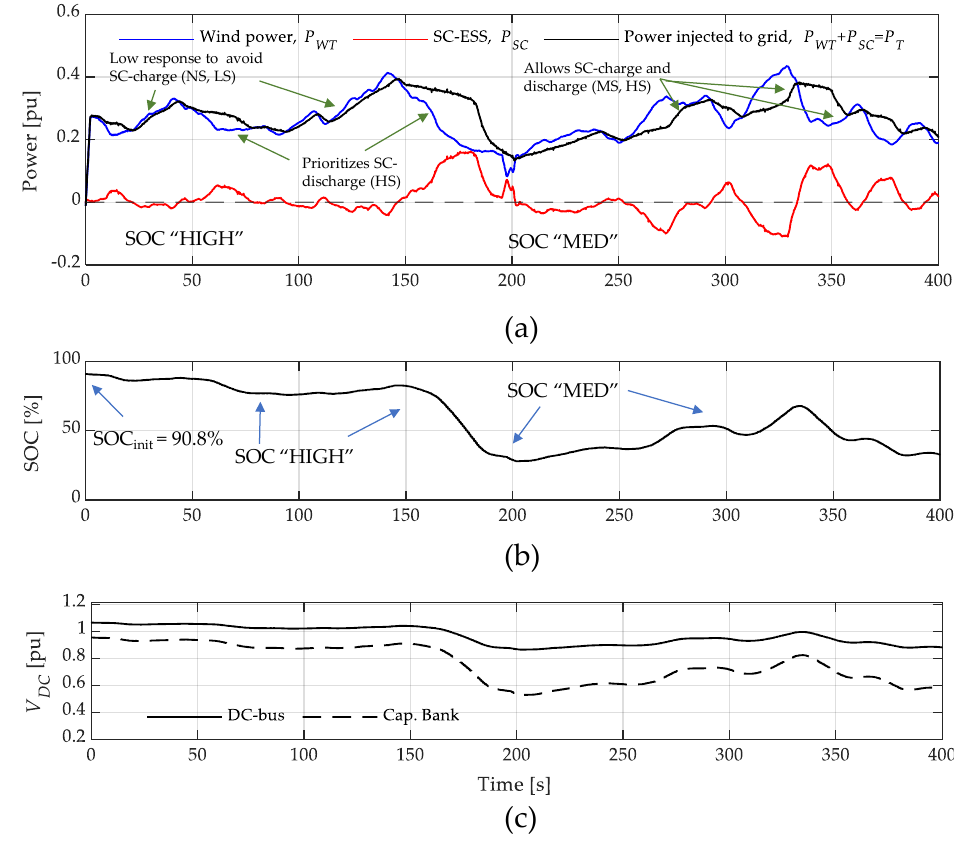
Figure 18. Experimental results in SC–ESS overcharge condition: ( a ) original injected wind power (blue), power delivered by SC–ESS (red), combined wind-supercapacitors effect with the smoothing algorithm (black); ( b ) evolution of SOC; ( c ) DC voltage of the supercapacitor array upstream of the inverter.